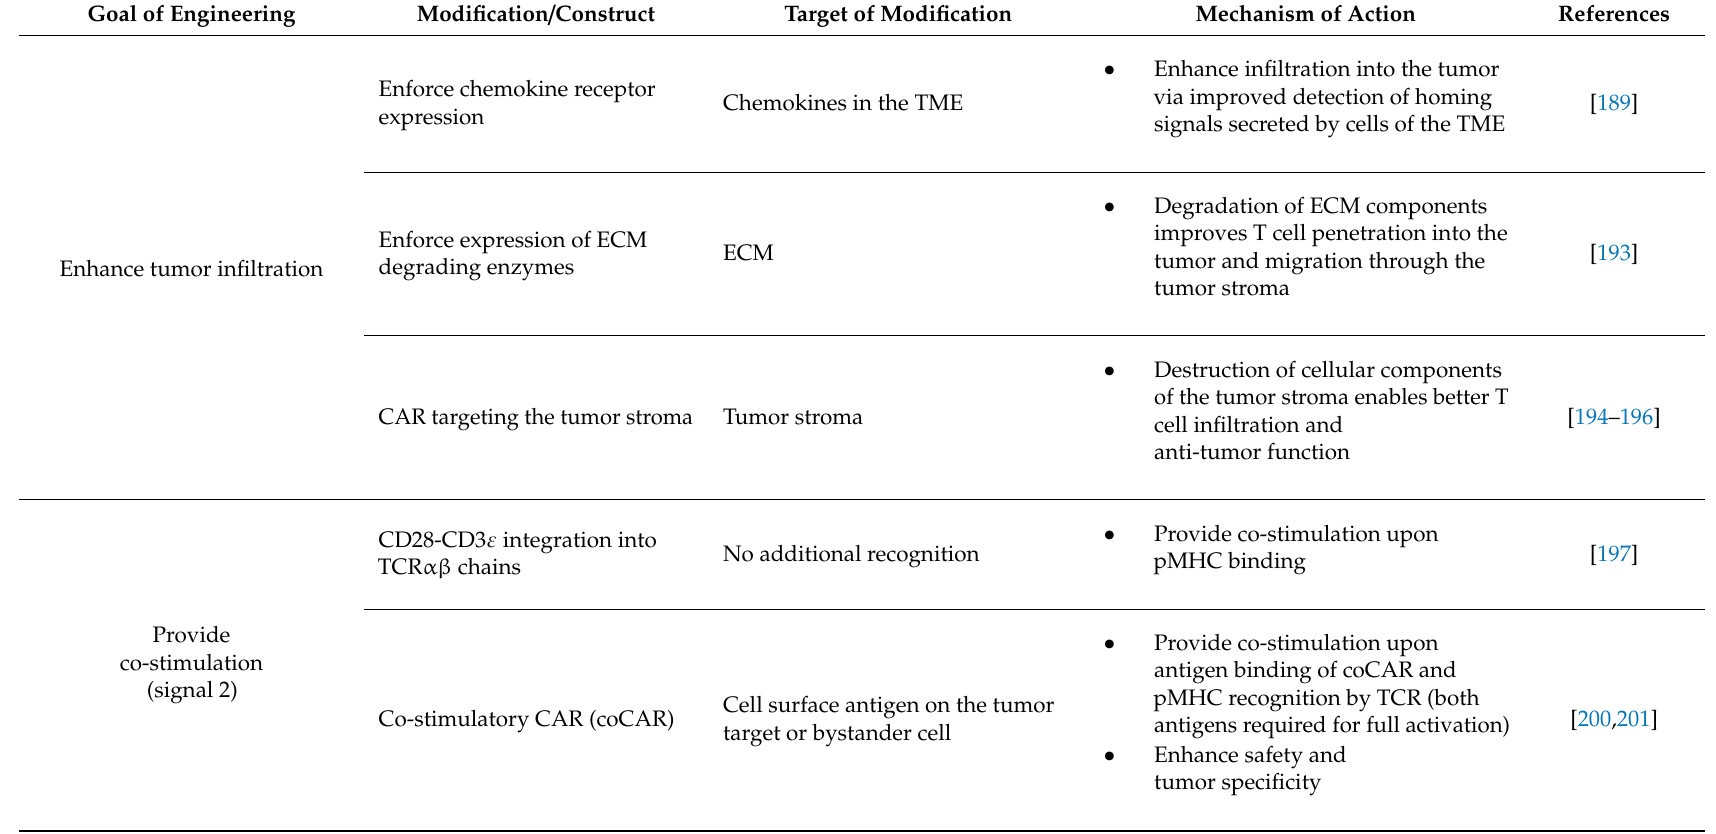
Table 2. Overview of engineering strategies targeting the TME. The overall goal of the listed strategies is to enhance tumor infiltration, and the persistence and function of adoptively transferred engineered T cells, by targeting and modulating TME